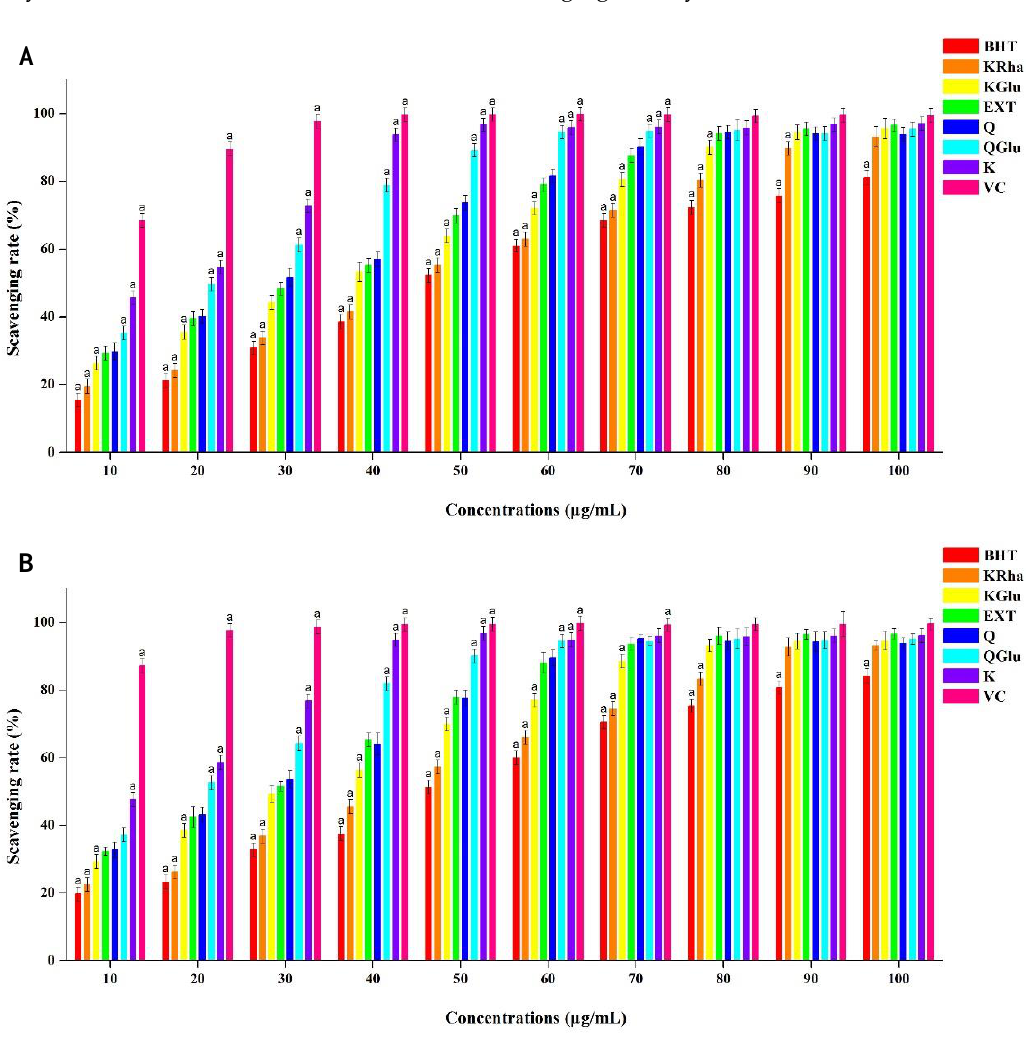
Figure 2. Antioxidant activities of the flavonoids extracted from C. paliurus leaves: ( A ) the DPPH radical-scavenging capacity and ( B ) the ABTS radical-scavenging capacity.BHT, butylated hydroxytoluene; KRha, kaempferol-7- O - α - L -rhamnoside; KGlu, kaempferol-3- O - β - D -glucuronide; Ext, extraction from C. paliurus ; Q, quercetin; QGlu, quercetin-3- O - β - D -glucuronide; K, Kaempferol; VC, vitamin C. Scavenging rates that were significantly different from EXT are indicated with a ( p <